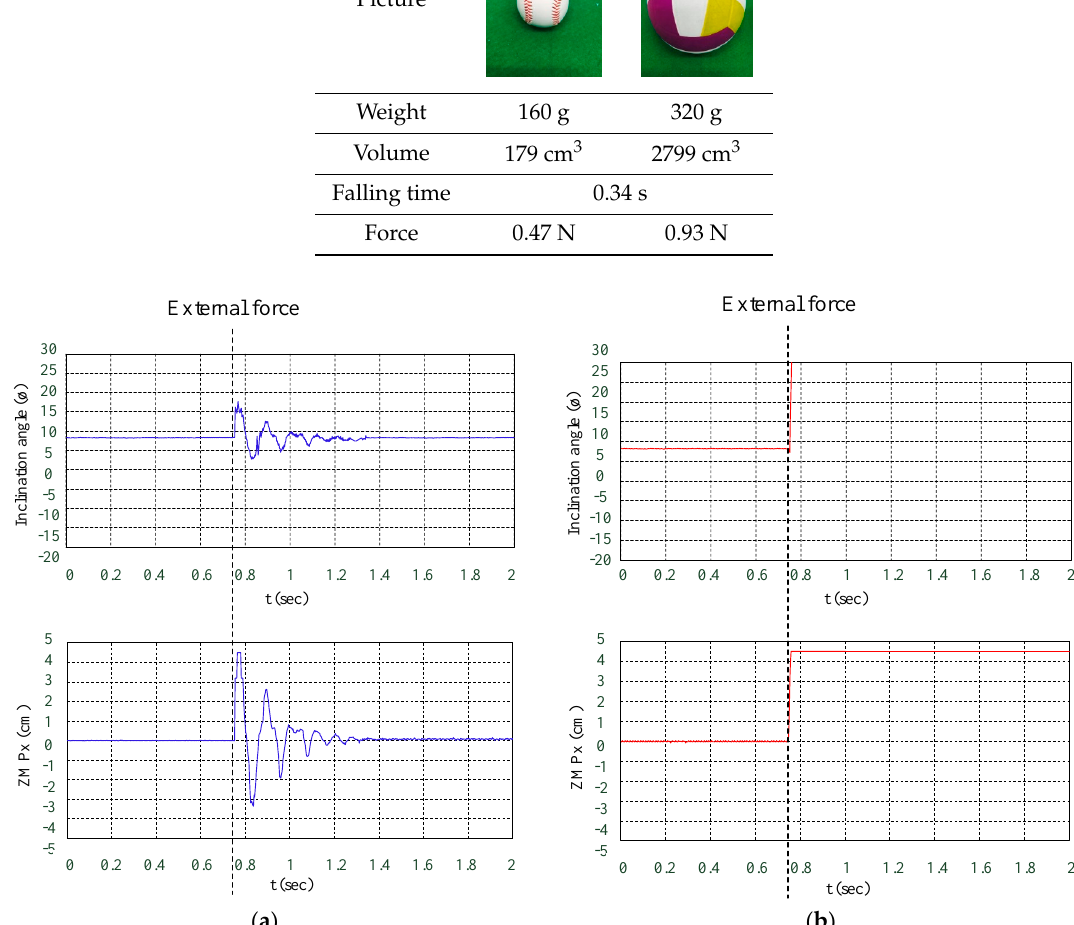
Figure 13. Experimental results of the TKU-X robot hit from the back by a baseball or a volleyball at 0.75 s when the balance control method is disabled. ( a ) Baseball. ( b ) Volleyball.